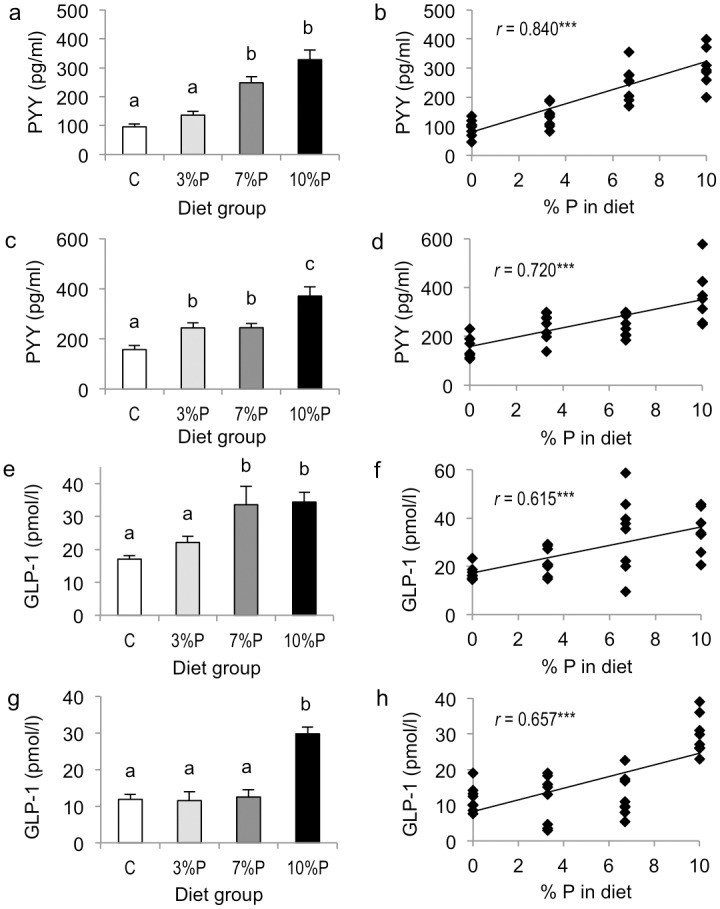
Satiety hormones.Plasma concentrations of PYY (a, c) and total GLP-1 (e, g) in rats offered control diet (C) or diet containing 3, 7 or 10% pectin (P) for 8 days (a, e) or 28 days (c, g); and correlations between amount of pectin in the diet and PYY and total GLP-1 concentrations in the 8-day (b, f) and 28-day (d, h) cohorts. Within figures, columns labelled with different letters are significantly different by one-way ANOVA, P<0.05, and r is the Pearson product-moment correlation coefficient, ***P<0.001.